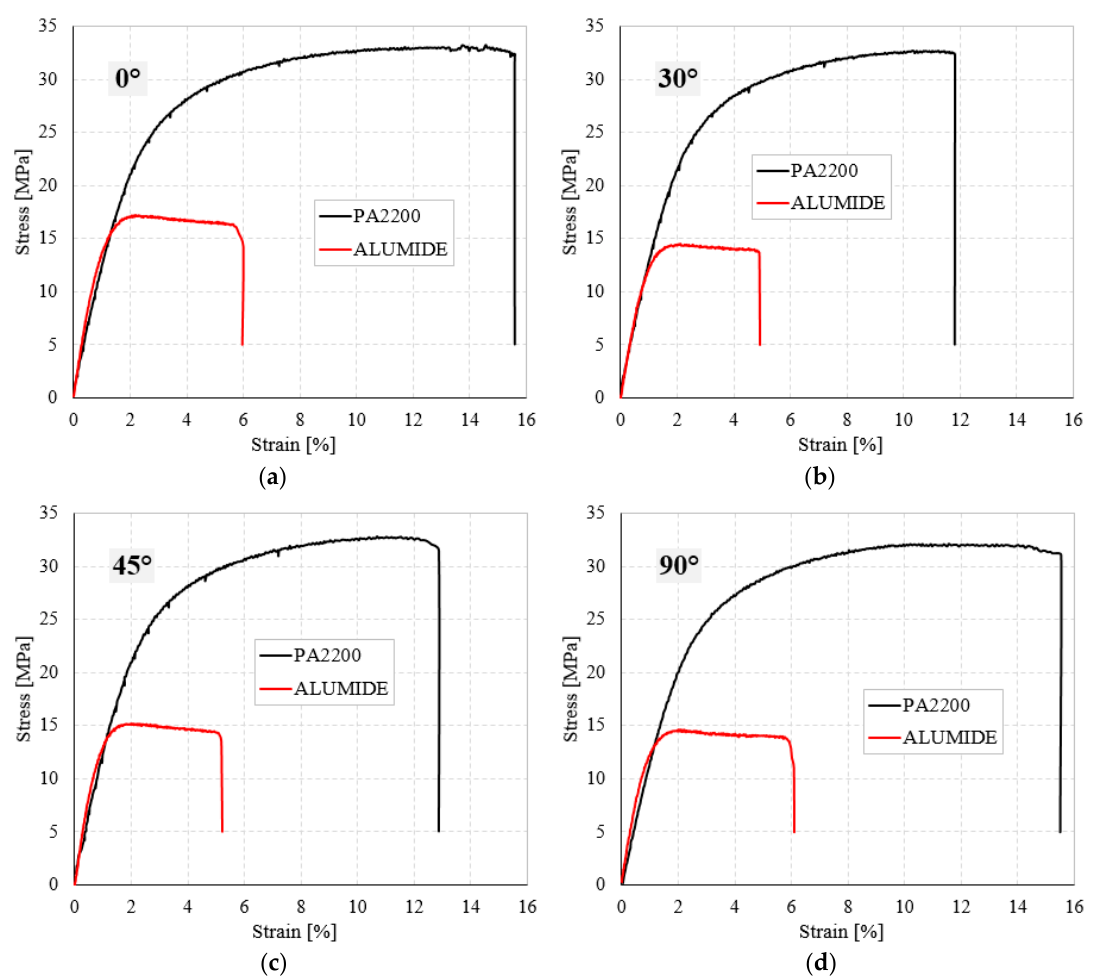
Figure 8. The experimental tensile stress-strain curves for PA2200 and Alumide samples at different orientation angle: ( a ) 0°; ( b ) 30°; ( c ) 45° and ( d ) 90°.